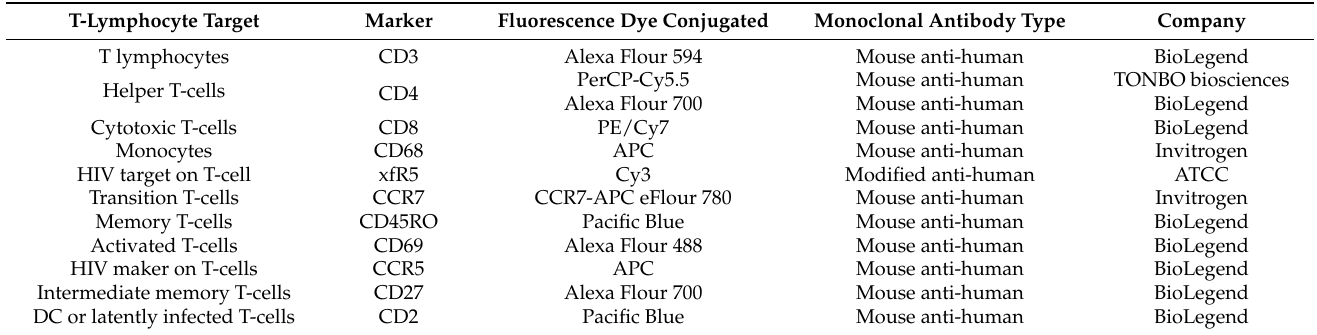
Table 1. Detailed information about different T lymphocyte phenotypic markers used for the im- munophenotypic